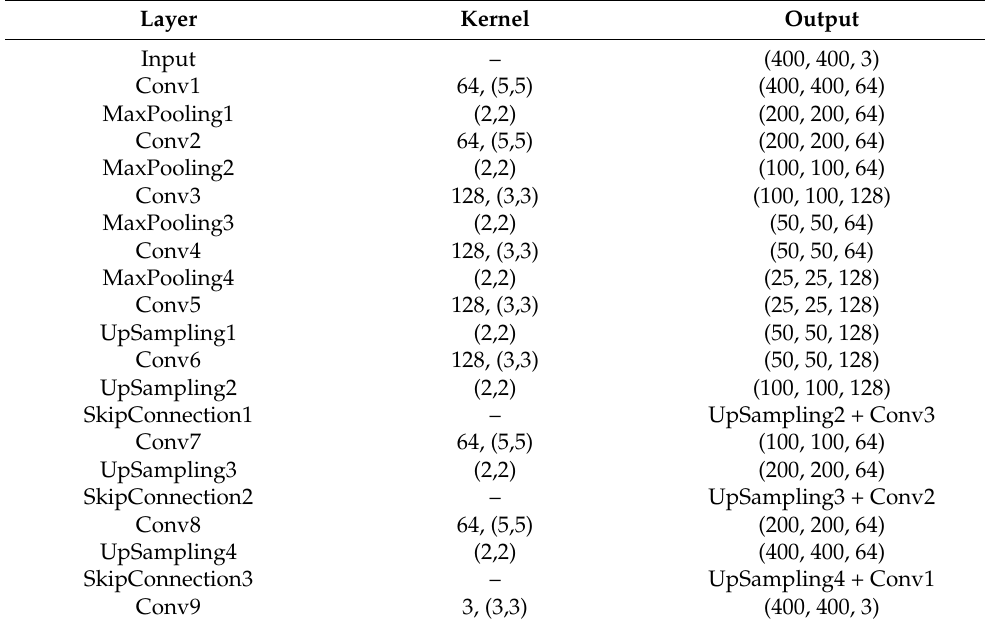
Table 2. Overall architecture of the skip-connected convolutional autoencoder. In the kernel column, the first number denotes the number of channels produces by the convolution, and the tuple of two number denotes the filter